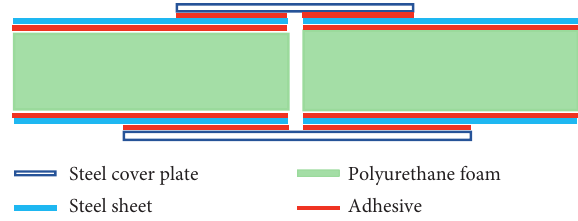
Figure 1: Cross-sectional area of the adhesively bonded poly- urethane-to-steel double butt joint.